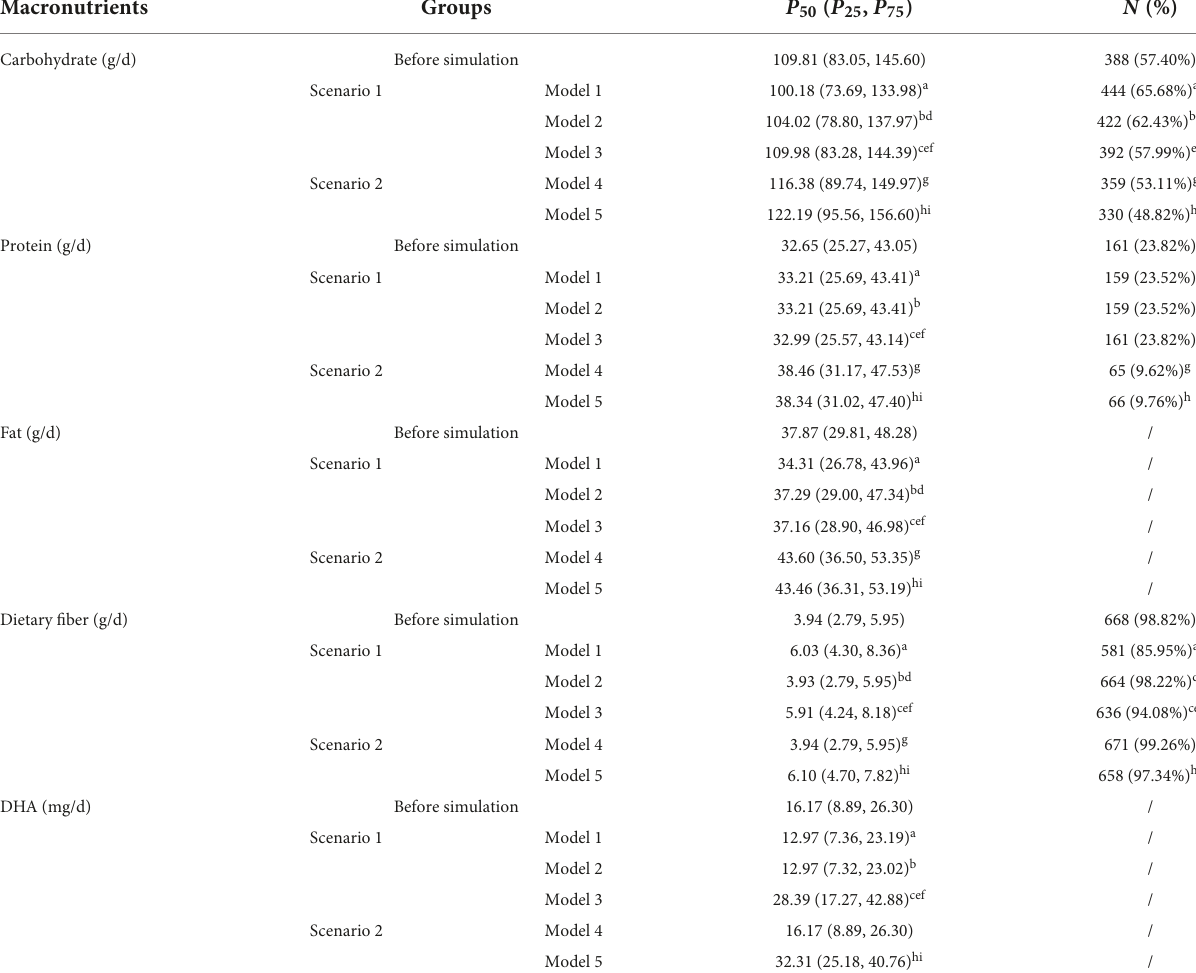
TABLE 3 Macronutrient intakes after simulation ( n =